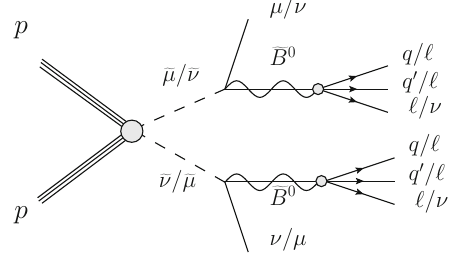
Fig. 5 Production of a smuon pair, smuon-sneutrino or a sneutrino pair, each decaying to a long-lived bino-like neutralino giving rise to a displaced